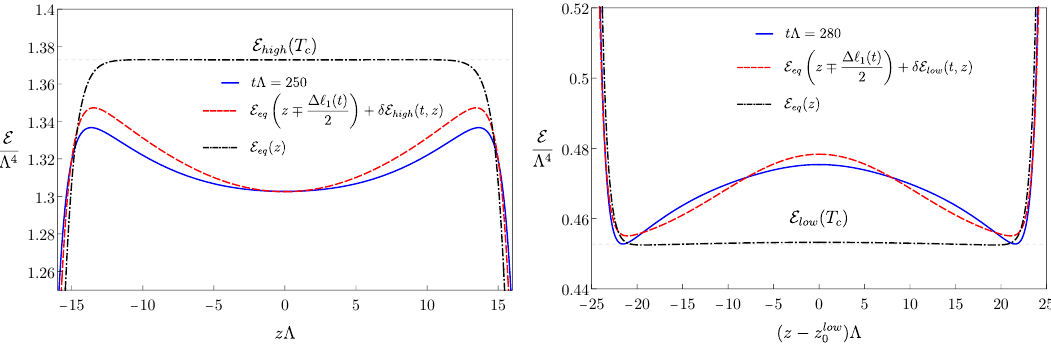
Figure 18 . Oscillations of the high- and low-energy phases during the relaxation period after the merger for the evolution in figure